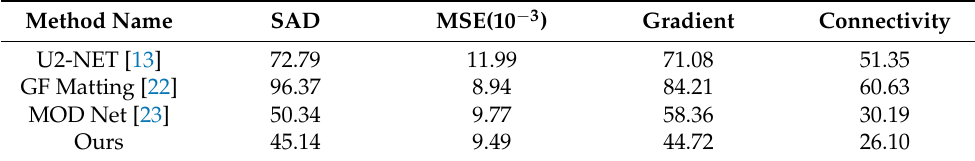
Table 2. Comparison of the results of several methods on the RealWorldPortrait-636 test set.